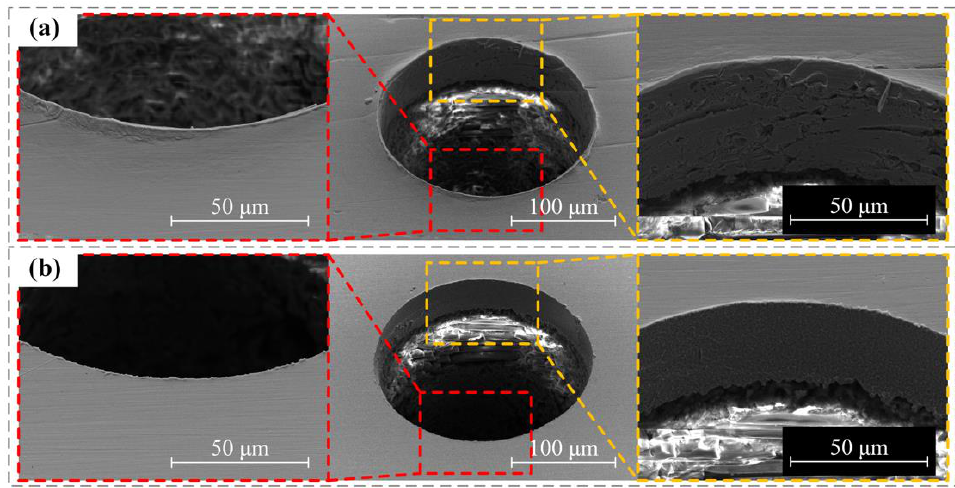
Figure 11. Micrographs of micro-holes machined by the two processes: ( a ) micro-hole machined by mechanical drilling; ( b ) micro-hole machined by micro-EDM.